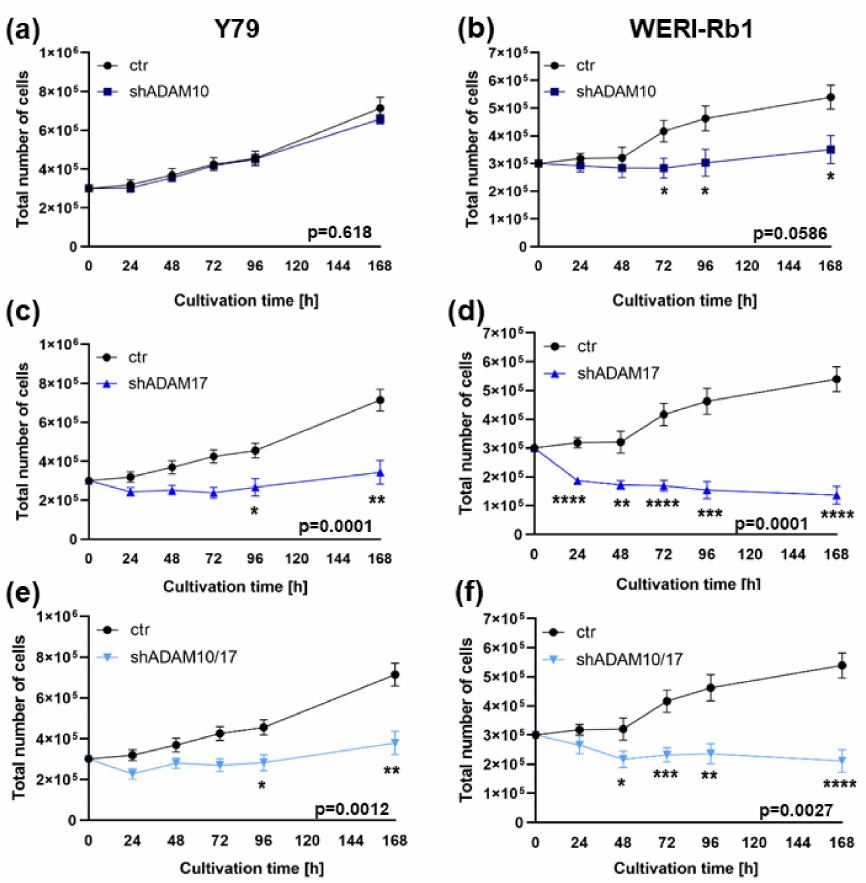
Figure 4. Effects of ADAM10/17 single and double knockdown on cell growth of RB cell lines. Stable ADAM10 (shADAM10), ADAM17 (shADAM17) and ADAM10/17 (shADAM10/17) knockdown decreases growth of Y79 ( a , c , e ) and WERI-Rb1 cells ( b , d , f ) compared to control cells (ctr) as revealed by growth curve analysis. Values are means of three independent experiments ± SEM. * p < 0.05; ** p < 0.01; *** p < 0.001 and **** p < 0.0001 statistical differences compared to the control (ctr) group calculated by Student’s t